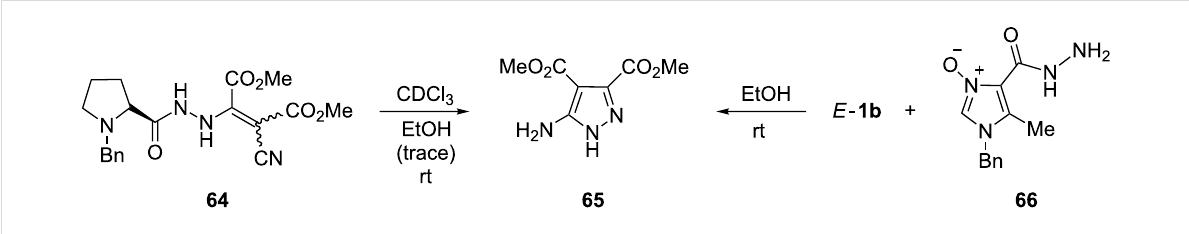
Scheme 21: Formation of 5-aminopyrazole-3,4-dicarboxylate 65 via heterocyclization